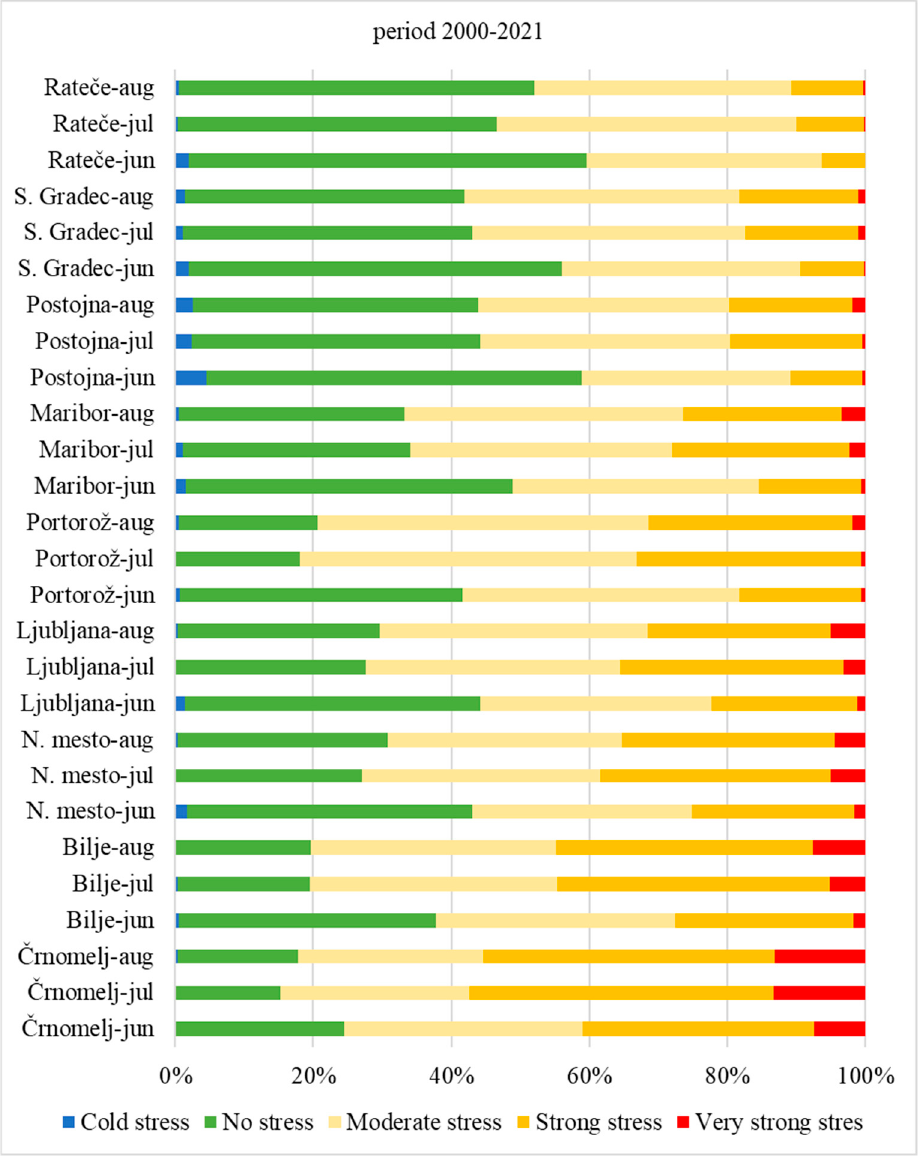
Table 7. Monthly and seasonal values of average, minimum and maximum number of days with strong heat stress (UTCI values above 32 °C) in the period 2000–2021 in Č rnomelj. Number of Days